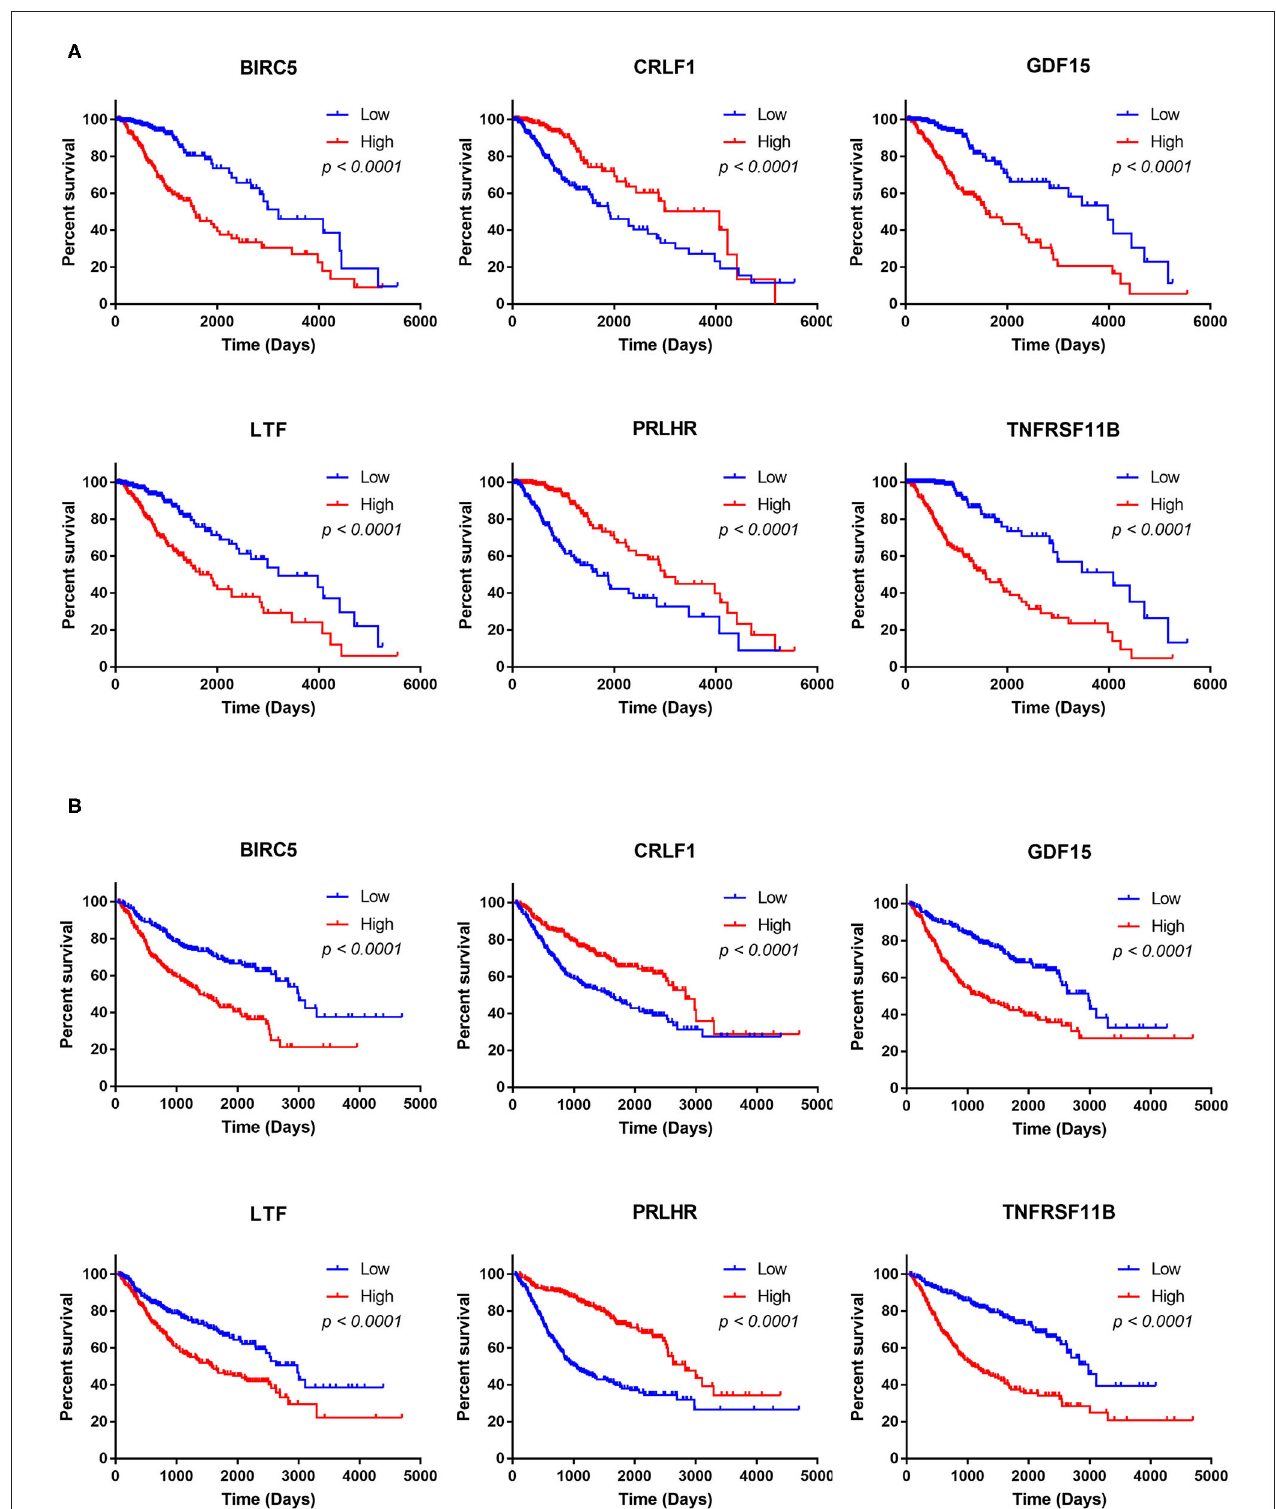
FIGURE 3 | Kaplan–Meier analysis of the six hub TMB-related genes (BIRC5, CRLF1, GDF15, LTF, PRLHR, and TNFRSF11B) in TCGA database (A) and CGGA database (B) .